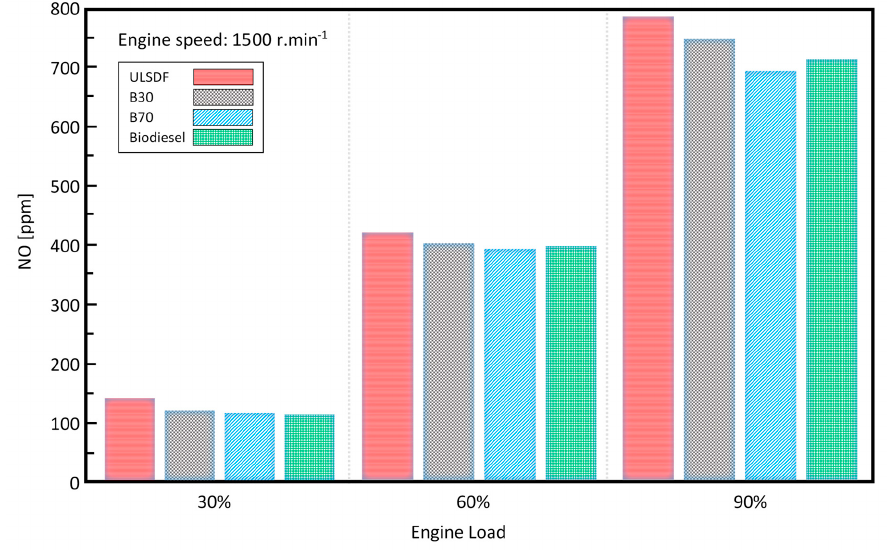
Figure 10. The dependence of testing fuels on the NO emissions (1500 rpm).